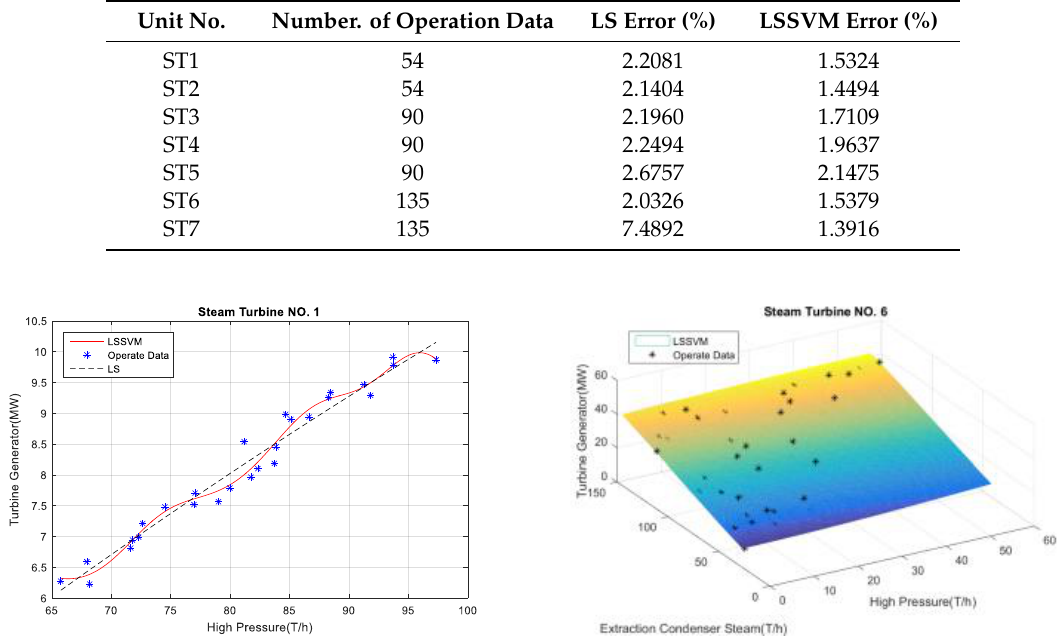
Figure 6. Example for the operation models of steam turbines (ST1/ST6).